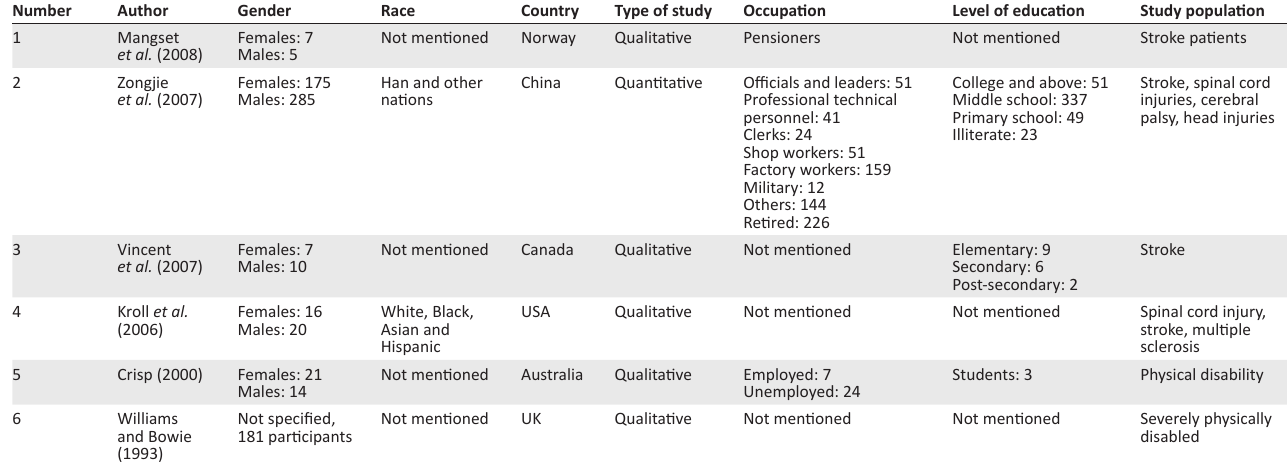
TABLE 3: Articles that were reviewed and met the criteria of the